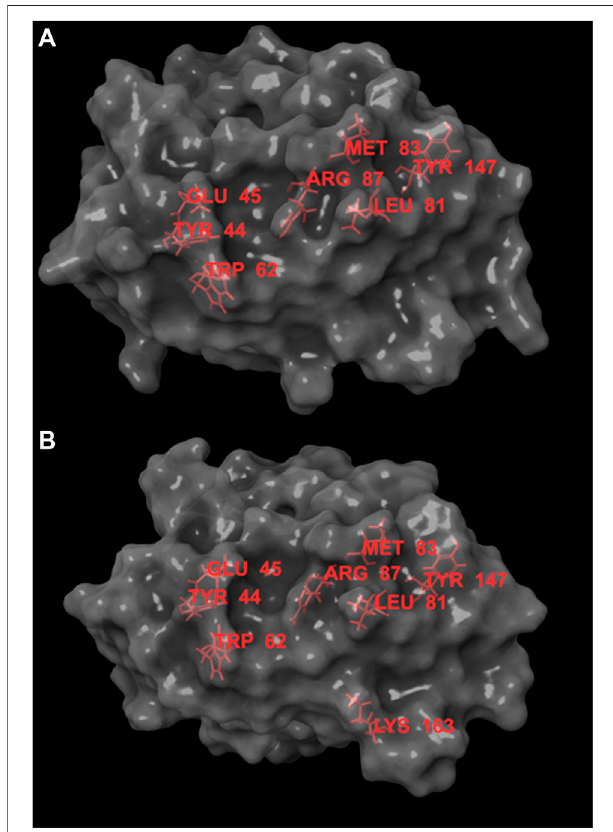
FIGURE 1 | Hot spots for JUNO structures 5JKC (A) and 5F4E (B) , the hot spots are marked in red. Hot spots are concentrated in an area narrow enough to be covered by molecules with MW ≥ 350. This area contains small grooves that can act as anchor points for ligands and provide partial protection from solvent.